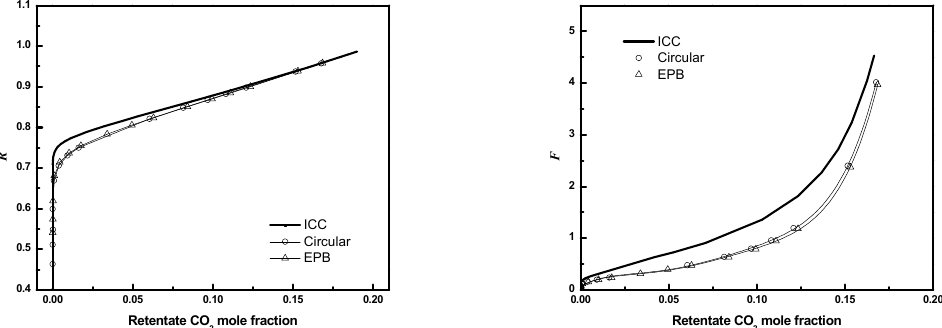
Figure 21. R or F as a function of CO 2 mole fraction for full 3-D circular module and EPB module ( N = 405, D / R f = 3, φ = 0.4. Circle, circular bundle; up triangle, EPB; solid line, ICC).